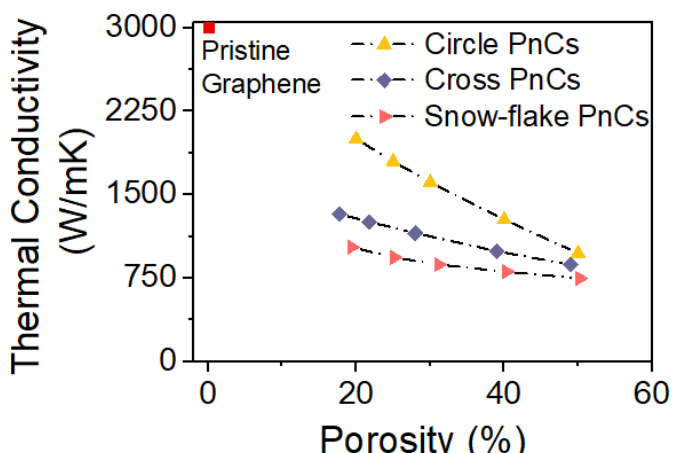
Figure 7. Supercell of the ( a ) circle, ( b ) cross, and ( c ) snowflake shaped graphene phononic crystal used for the thermal conductivity